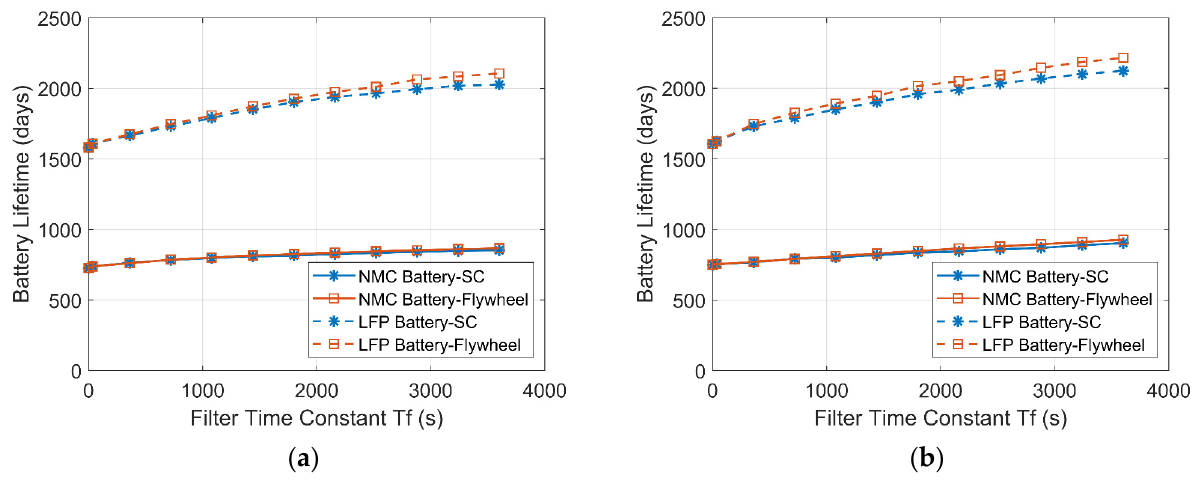
Figure 21. Estimate lifetimes of batteries in the HESSs with increasing time constant. ( a ) Wind-powered household-prosumer system. ( b ) PV-powered household-prosumer system.